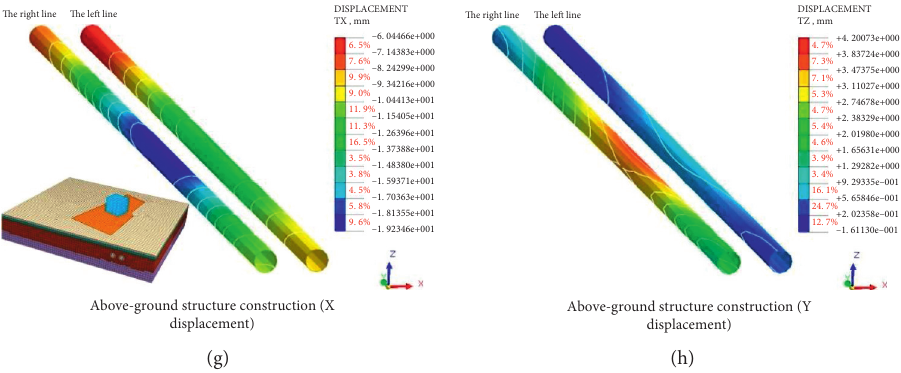
Figure 6: Tunnel deformation induced by construction. (a) Foundation pit excavation ( X displacement). (b) Foundation pit excavation ( Y displacement). (c) Underground structure construction ( X displacement). (d) Underground structure construction ( Y displacement). (e) Basement backfill ( X displacement). (f) Basement backfill ( Y displacement). (g) Above-ground structure construction ( X displacement). (h) Above-ground structure construction ( Y